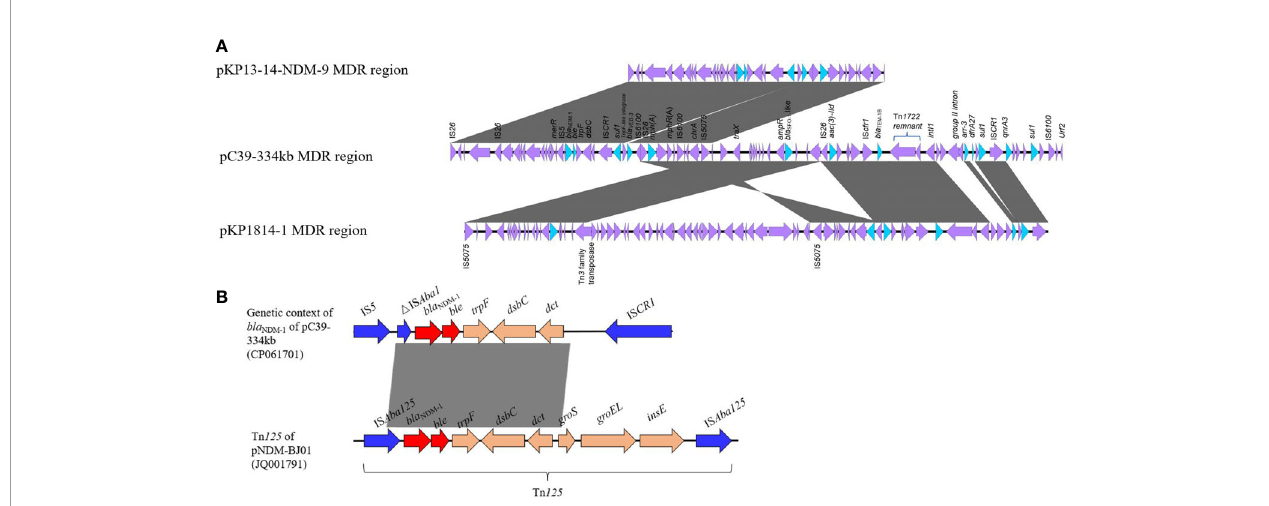
FIGURE 3 | (A) Linear comparison of MDR regions among pC39-334kb, pKP13-14-NDM-9 (MN175386), and pKP1814-1 (KX839207). (B) Comparative analysis between genetic context of bla NDM-1 in pC39-334kb and Tn 125 . The sequence of Tn 125 is derived from pNDM-BJ01 (JQ001791) in Acinetobacter lwof fi i .